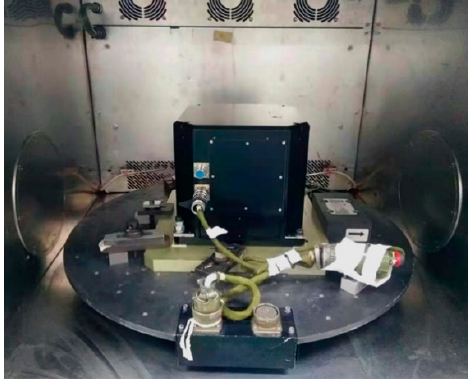
Figure 5. The two-axis turntable with a thermal chamber.